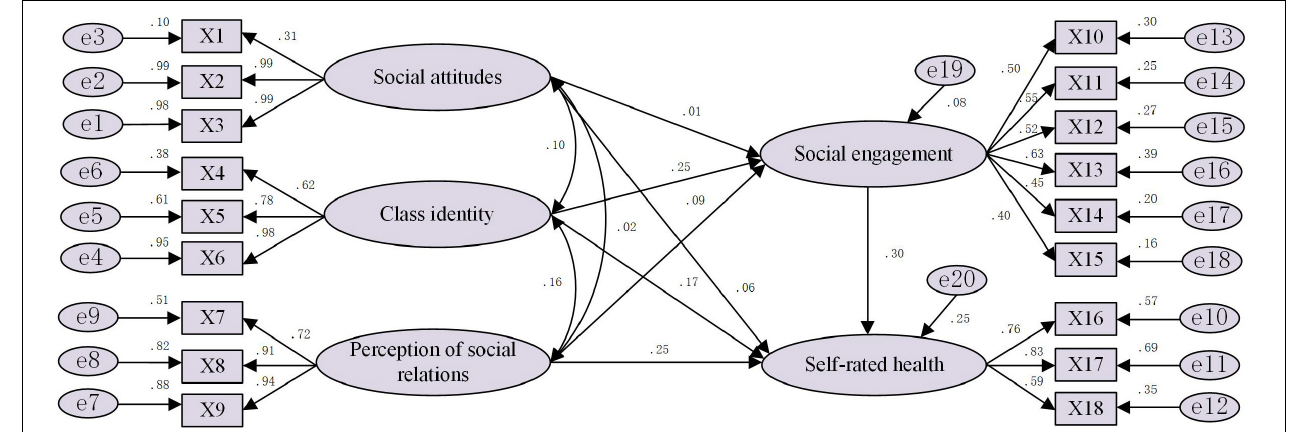
FIGURE 2 | Path estimation results for the structural equation